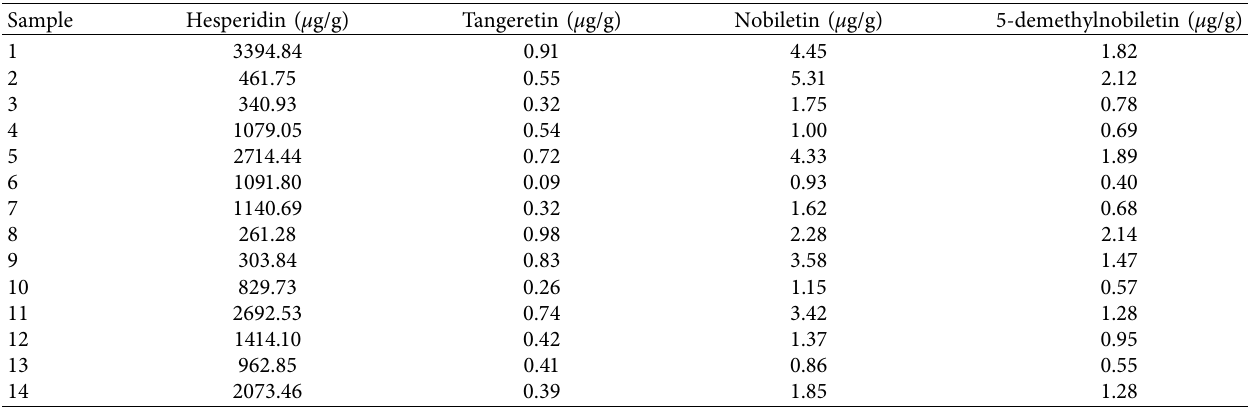
Table 7: Relative content of four